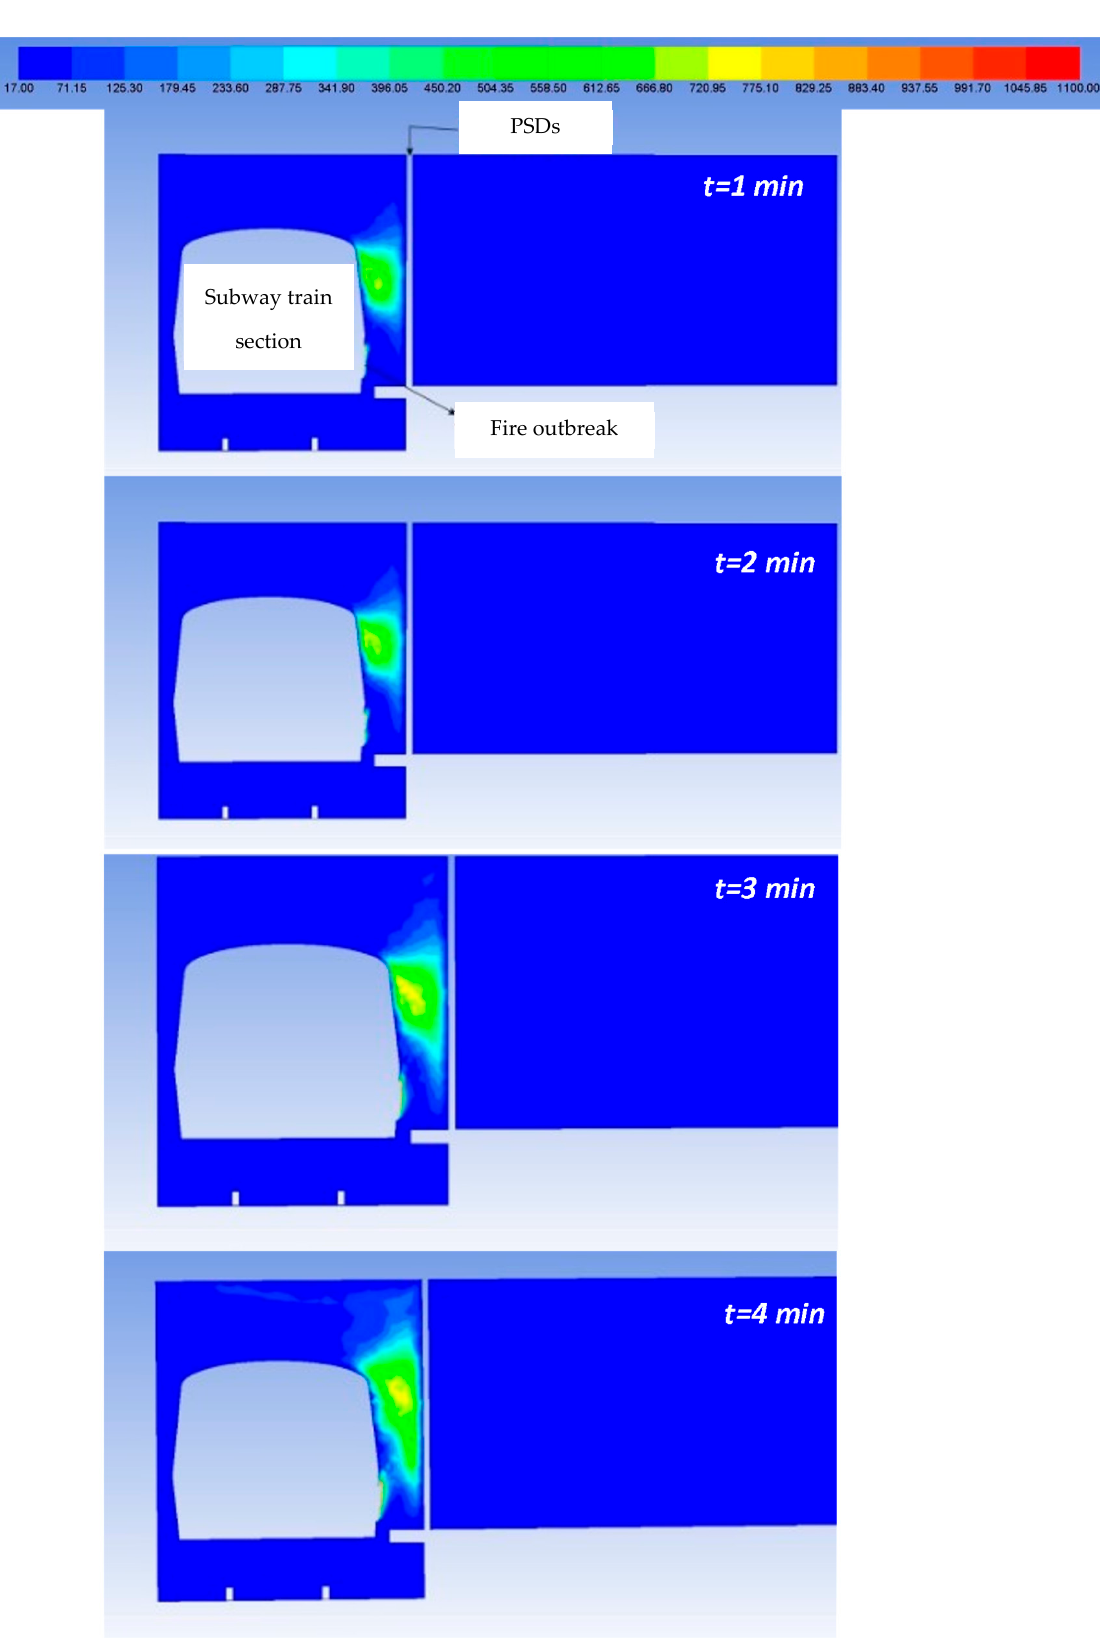
Figure 12. Temperature contours (°C)—cross section through the fire outbreak (minutes 1–4).